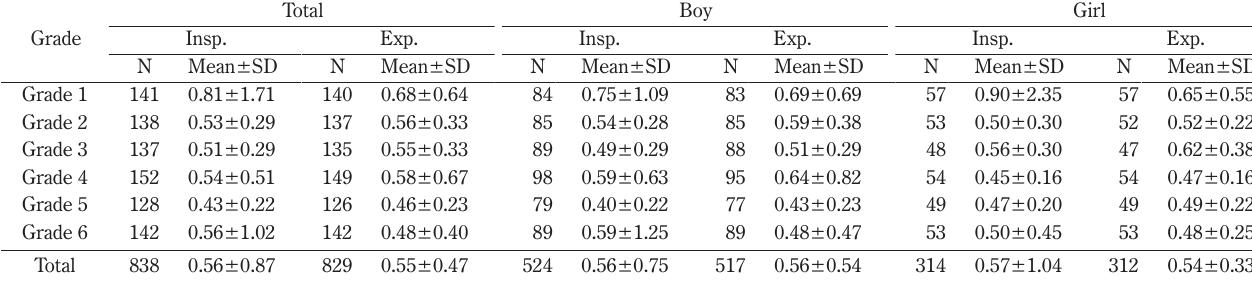
Table 3 Bilateral nasal resistance in naso-sinal morbid children and grades of elementary school